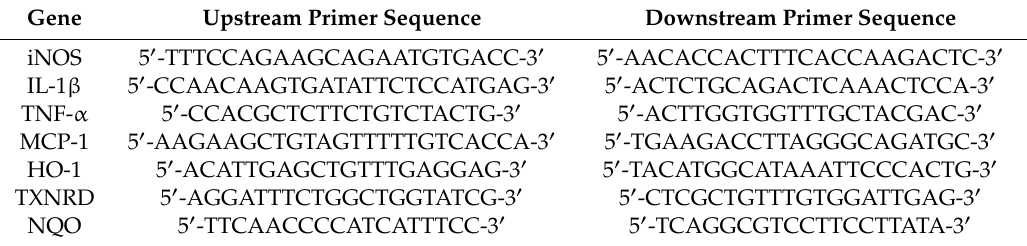
Table 2. The real-time PCR-related primer sequences